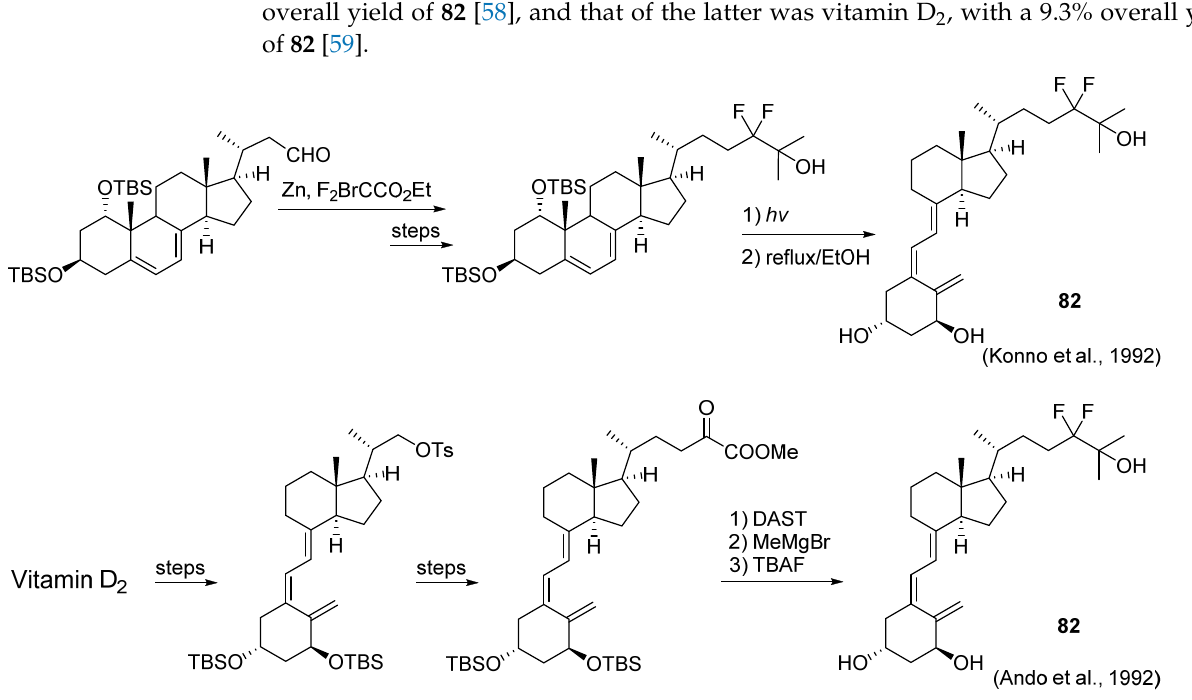
In 1992, two alternative linear synthetic routes to 24,24-difluoro-1 α ,25(OH) 2 D 3 ( 82 ) were reported by Takayama et al. using the Reformatsky reaction with ethyl bromodi- fluoroacetate or Horner–Emmons reaction as the key step, respectively (Scheme